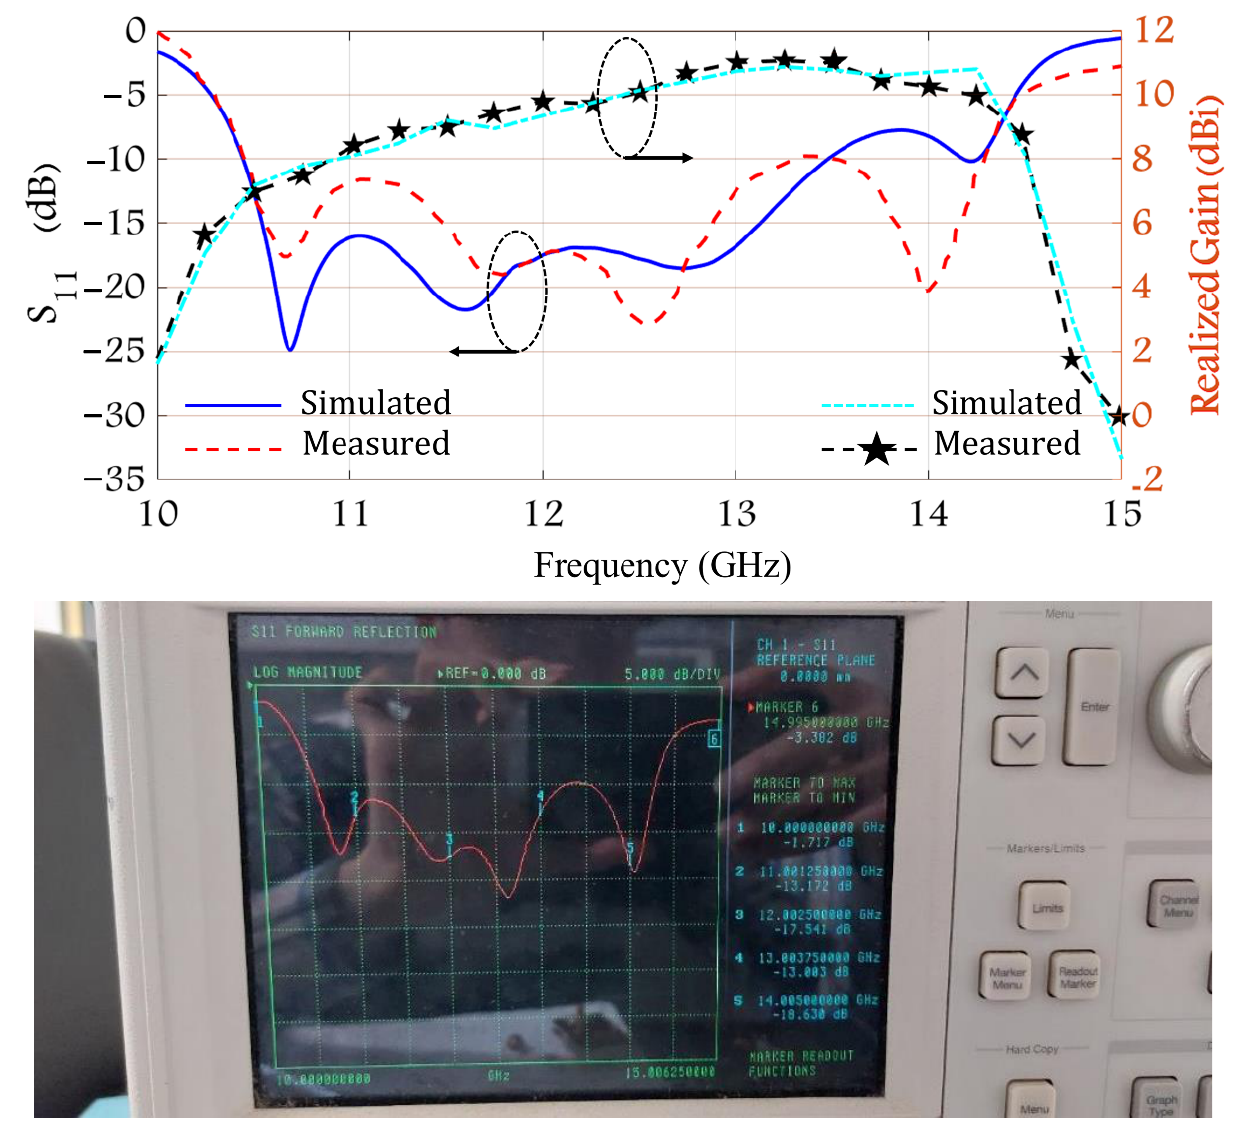
Figure 4. Simulated and measured S 11 and the realized gain of the fabricated patch array.